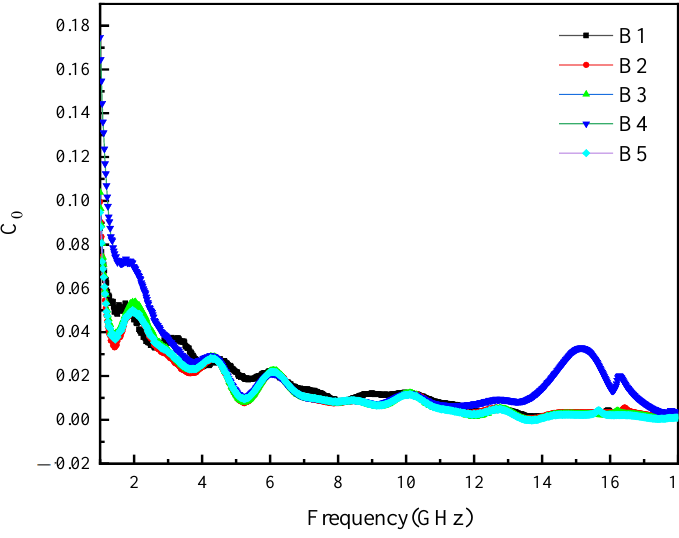
Figure 7. Eddy current loss of the samples with different contents.